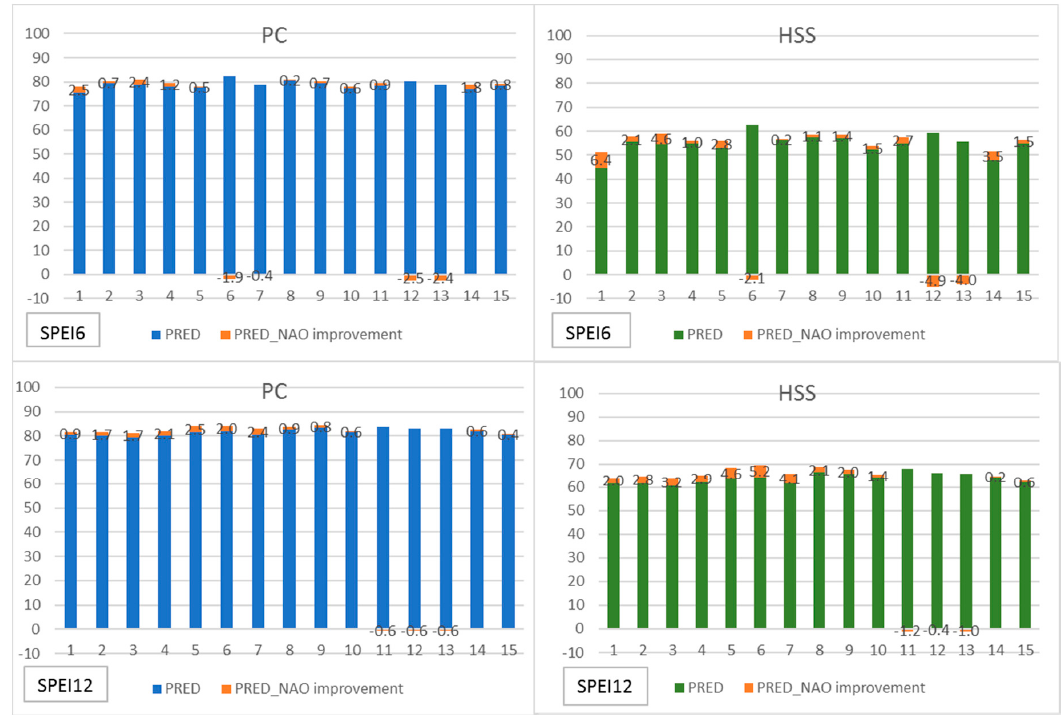
Figure 6. PC and HSS improvement (%) considering the influence of NAO on the SPI6 and SPI12 modeling for the extended winter months for each of the 15 grid points. Water 2018 , 10 , 65